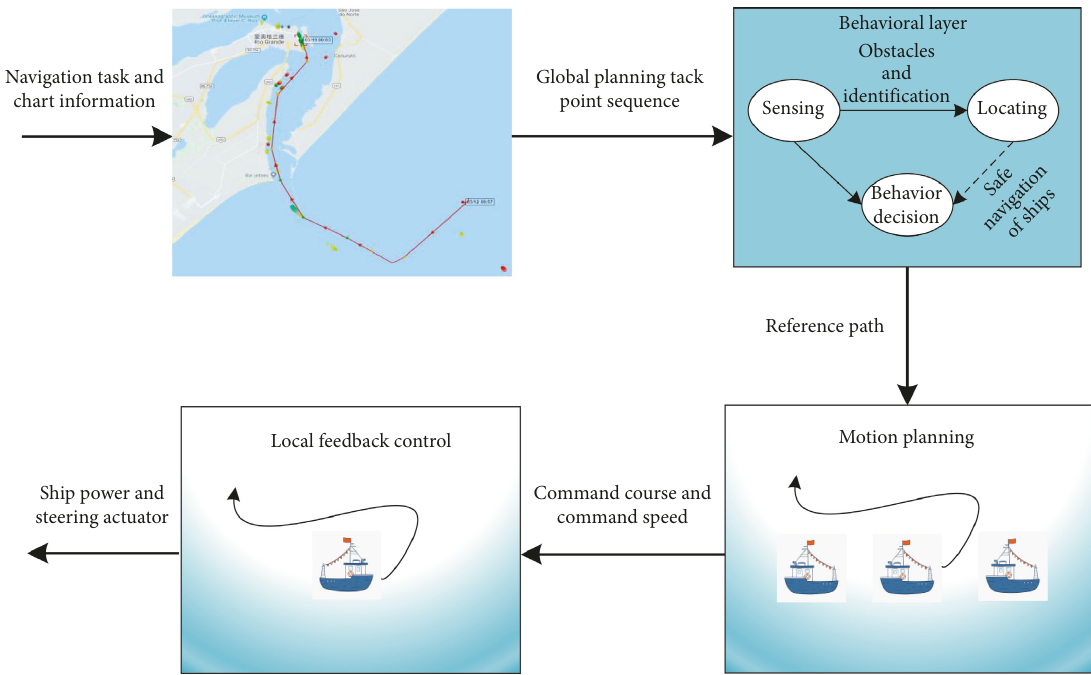
Figure 1: IASV planning and control